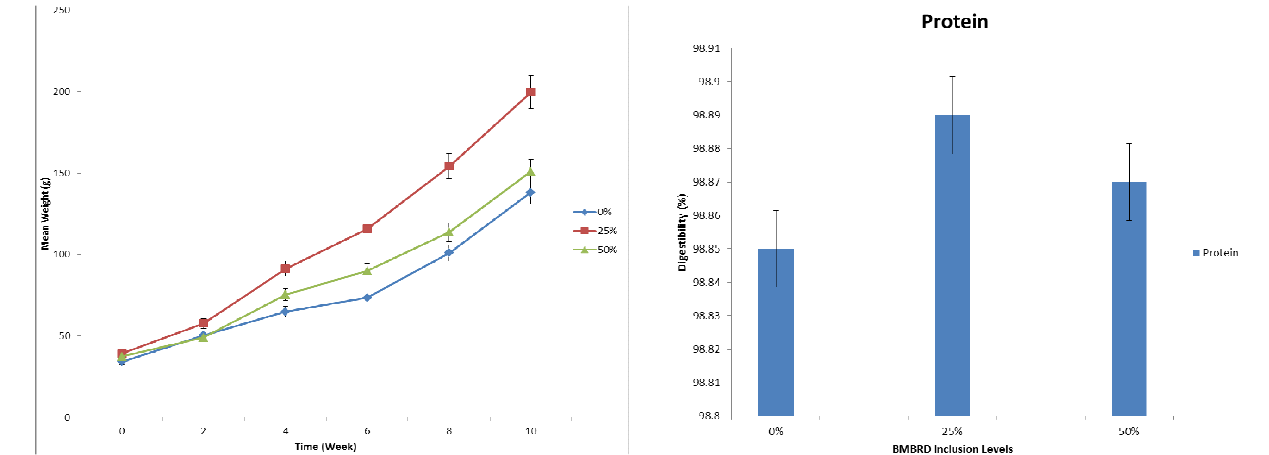
Fig. 1. Weight gained by Clarias gariepinus juveniles fed the experimental diets during the period of study